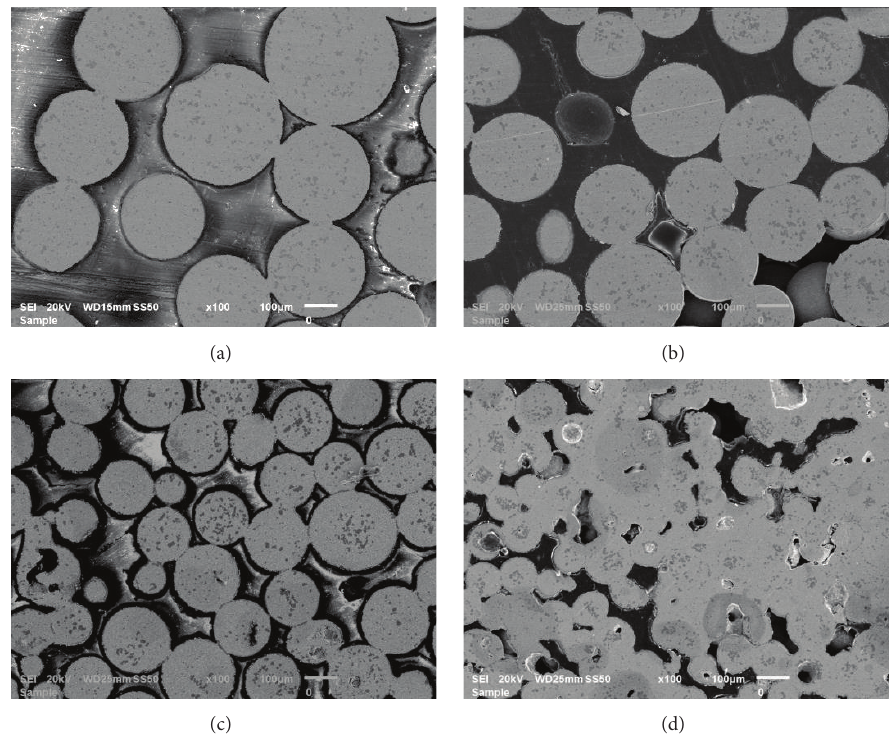
Figure 7: Scanning electron micrographs of the samples sintered at 1150 ∘ C for 80 min: (a) sample A (+50 mesh), (b) sample B (50 ∼ 70